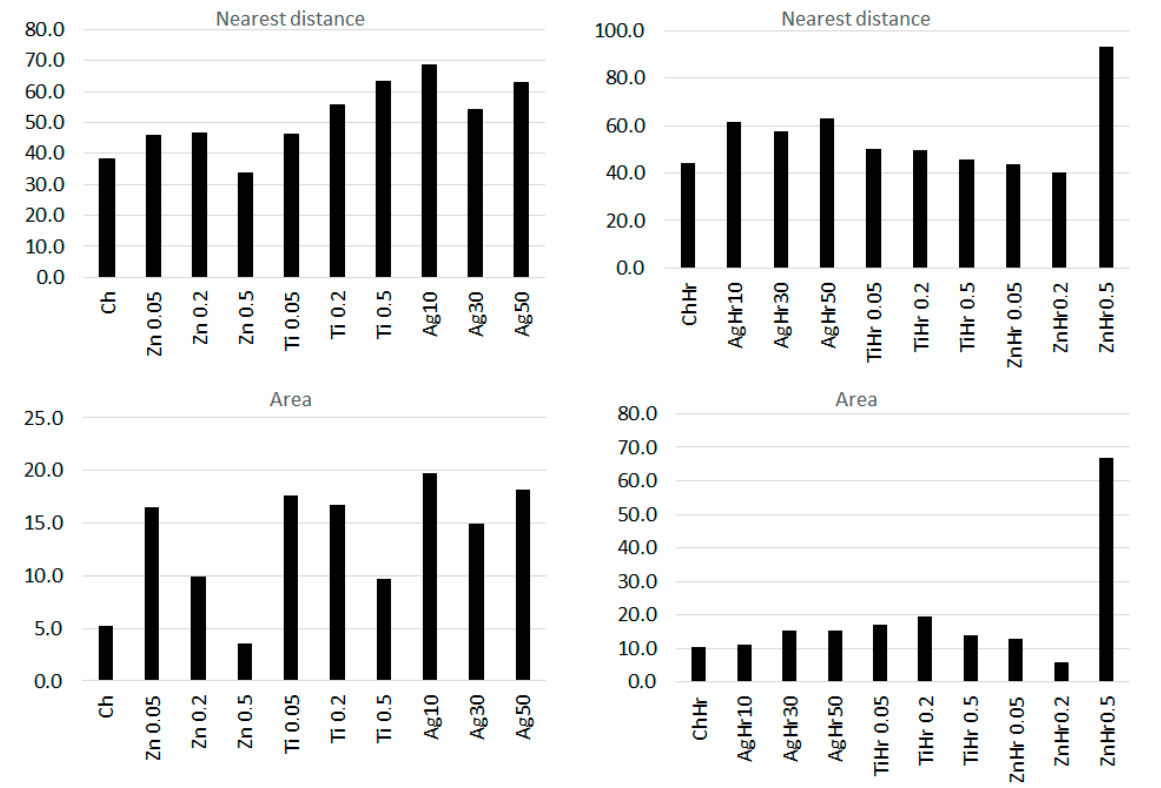
Figure 15. Comparison of the nearest object distance and area in edible films.